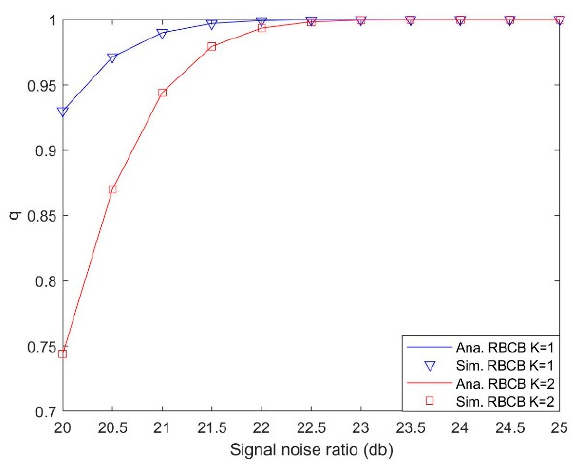
Figure 12. Comparison of 𝑞 .